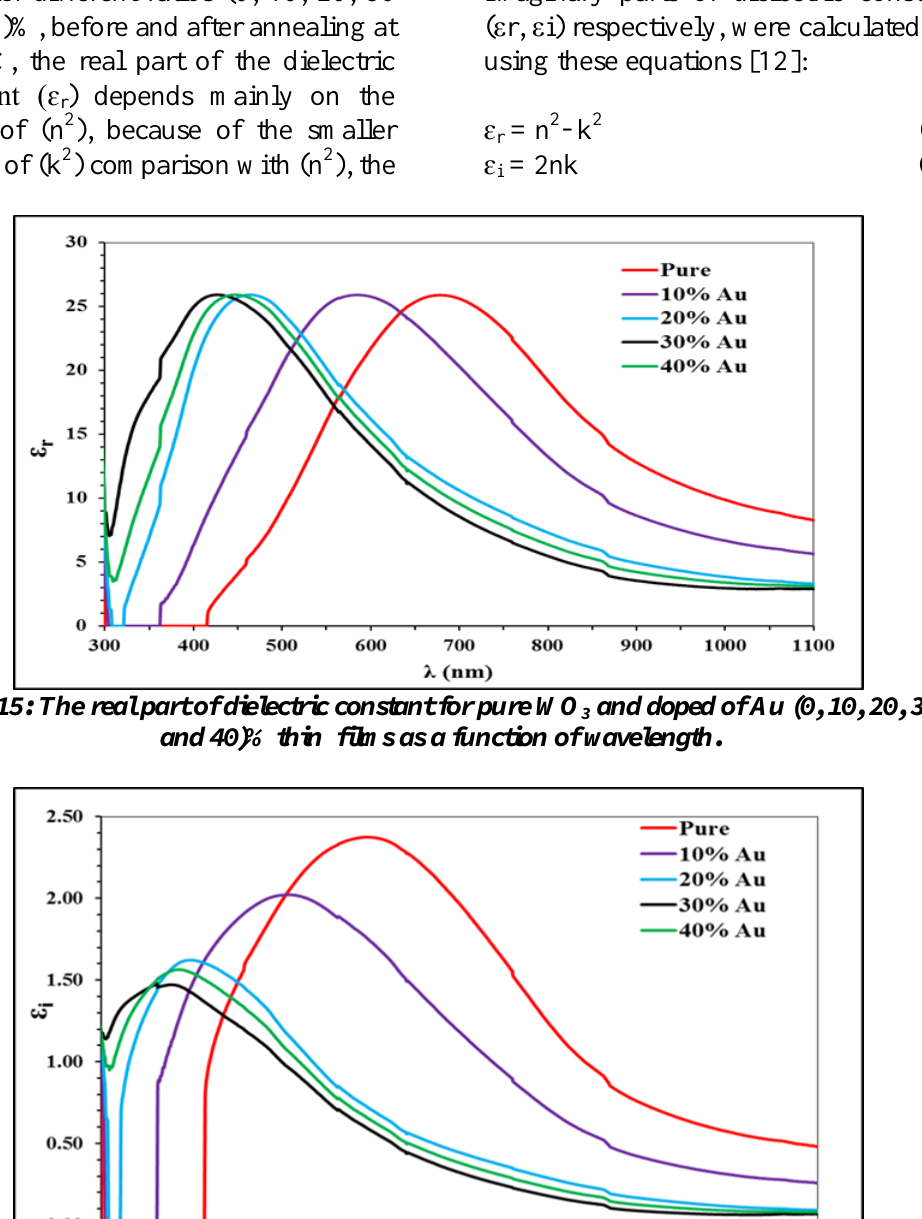
Fig. 16: The imaginary part of dielectric constant for pure WO3 and doped of Au (0, 10, 20, 30 and 40)% thin films as a function of